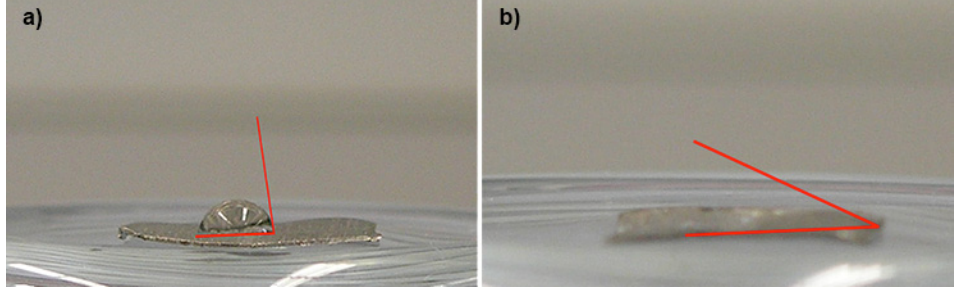
Figure 3. Wettability tests. ( a ) On the titanium surface of the control group. ( b ) On the surface treated with carboxyethylphosphonic acid.